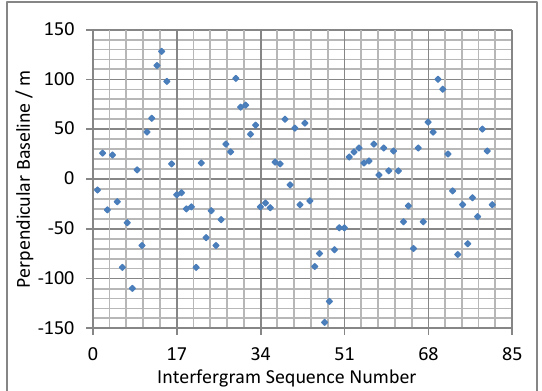
Figure 5: Perpendicular baselines of the analysed interferograms